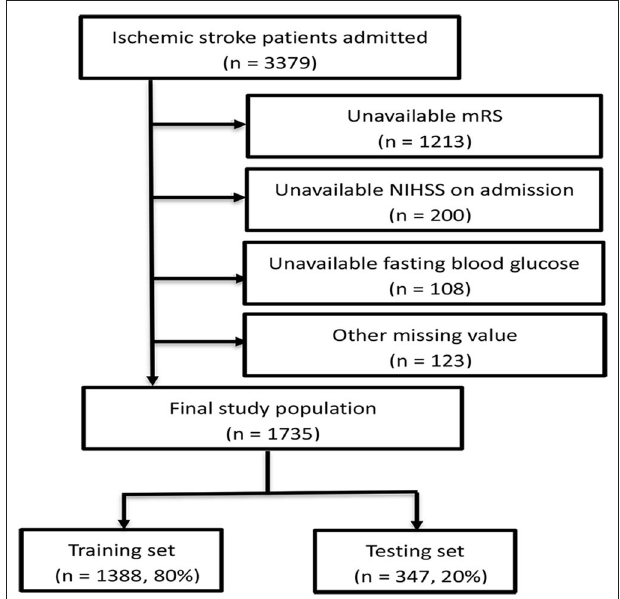
FIGURE 1 | Flow chart illustrating patient selection. mRS, modified Rankin Scale; NIHSS, National Institute of Health stroke scale.